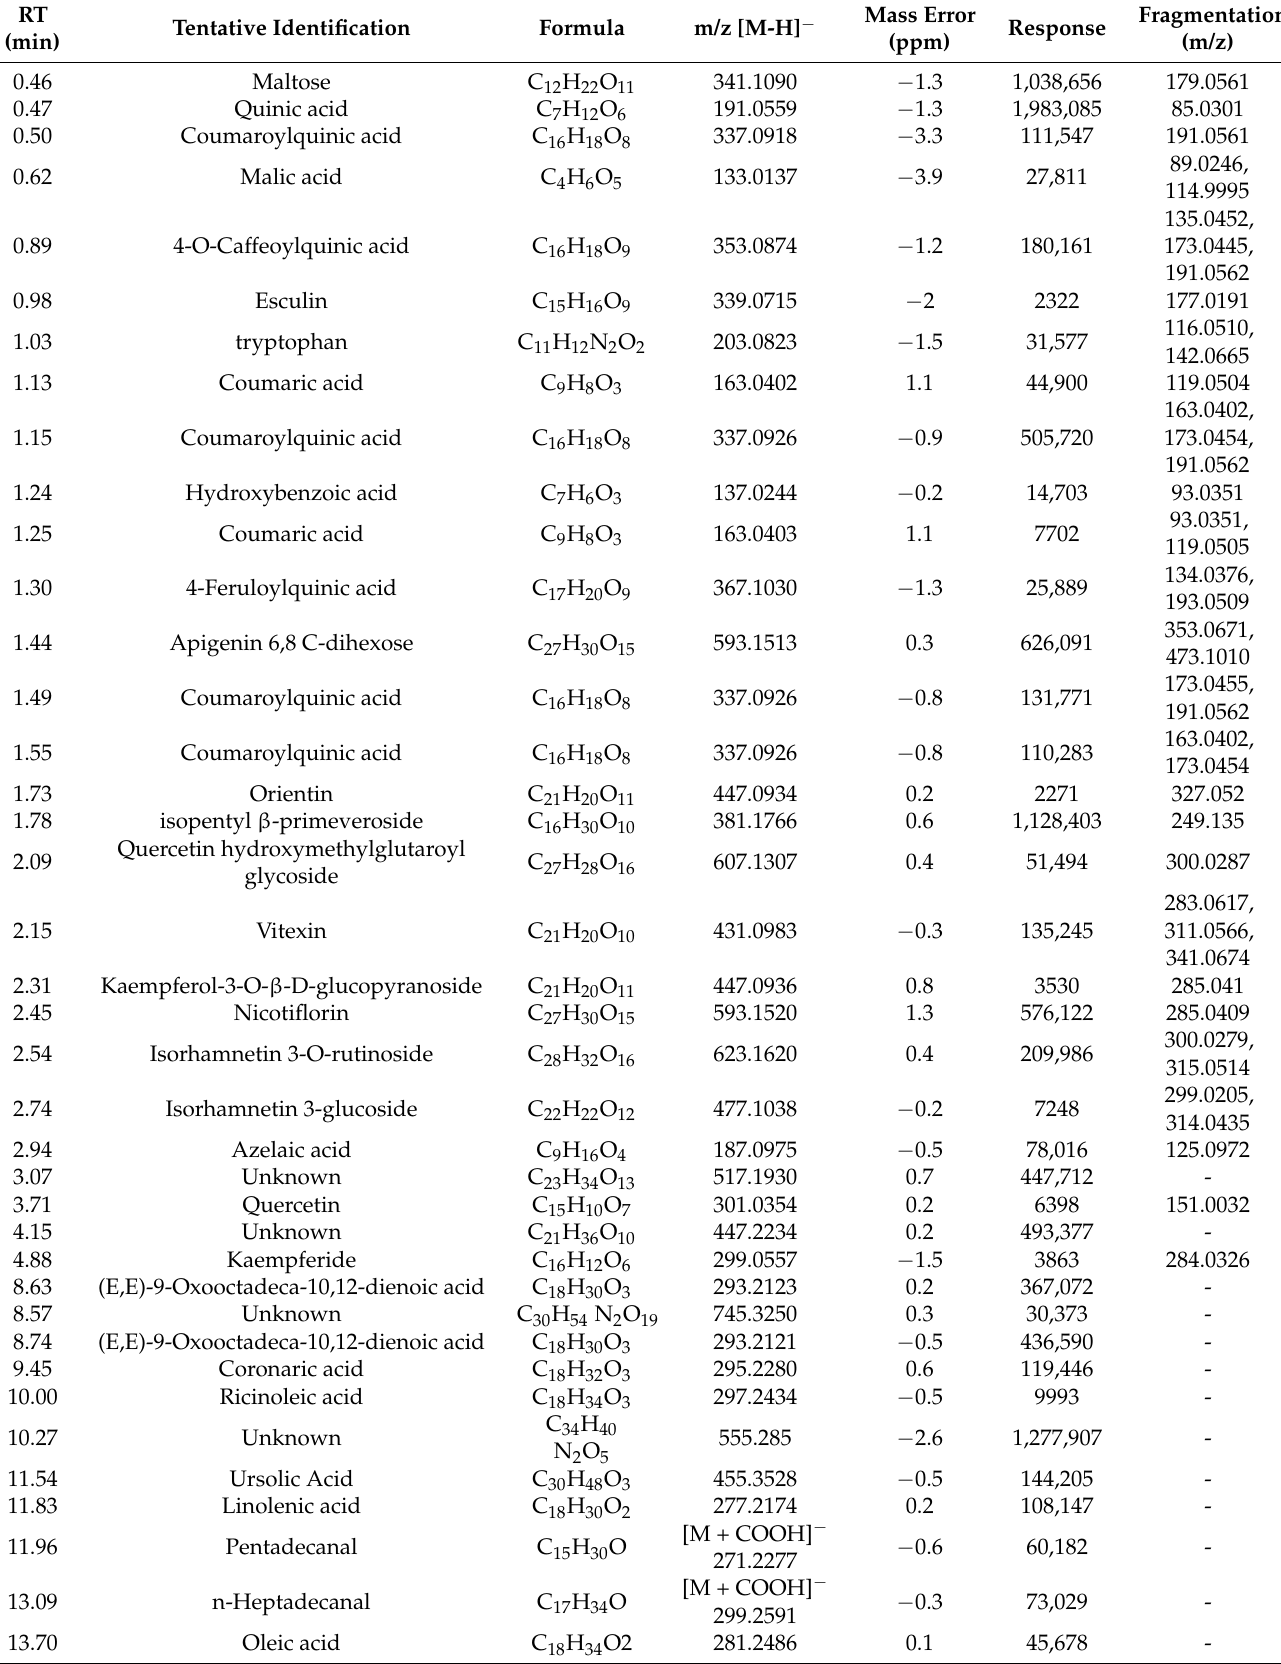
Table 1. Phytochemical profiling of M. concanensis